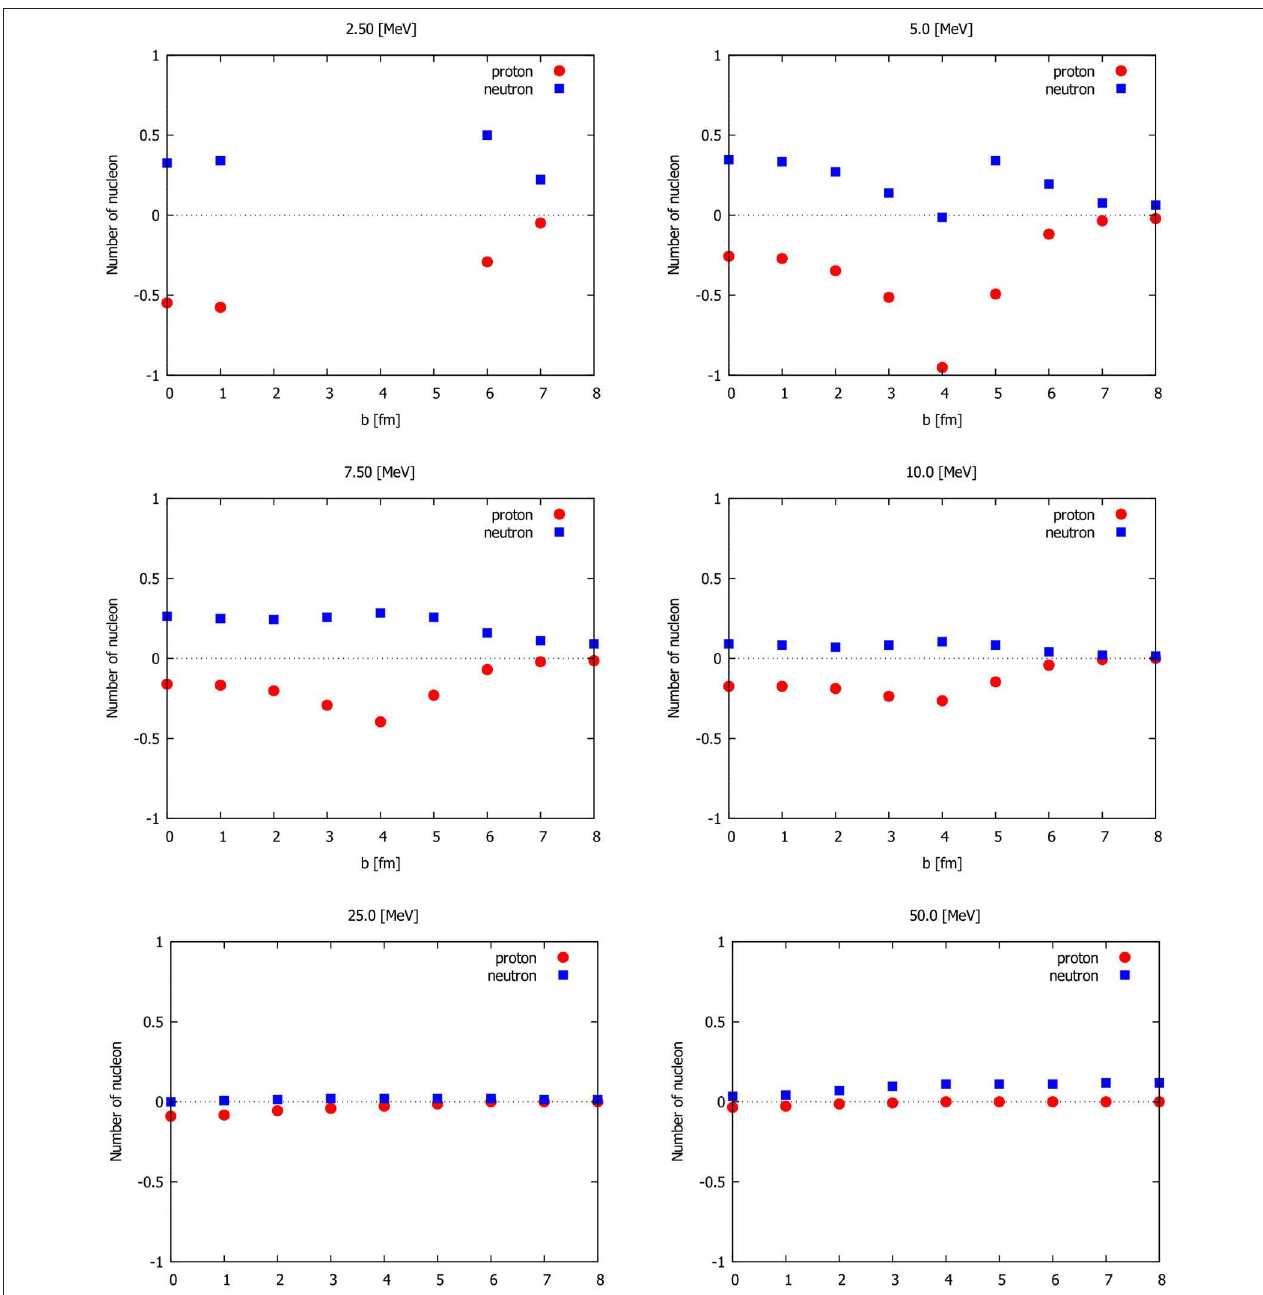
FIGURE 5 | For collisions 8 He + 4 He, transferred nucleon from 8 He to 4 He are shown depending on the relative velocity of the collisions. The impact parameter dependence with six different energies E K are shown. Red circles show the amounts of neutron transfer, and the blue squares show those of proton transfer. In a low energy case with E K 2.50 MeV and b = 2, 3, 4, 5 fm, fusion appears. =